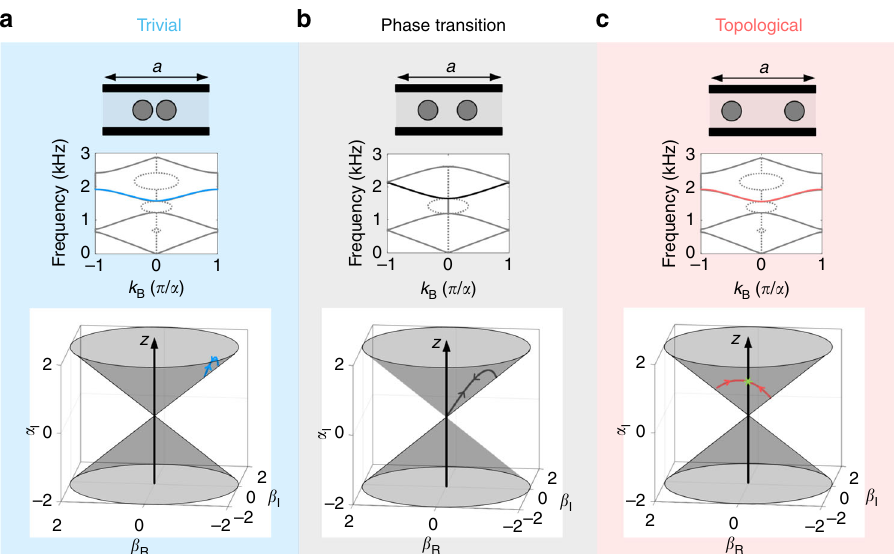
Fig. 6 Topology of the bands. We de fi ne the topology of the bands as the number of times the contours C crosses the axis of the cone de fi ned in Eq. 20. a For the trivial lattice, the contour C does not cross the axis of the cone, corresponding to a zero topological invariant. b When the system goes through phase transition, the contour C touches the tip of the cone. The topological invariant cannot be de fi ned in this case. c Same as panels ( a ) and ( b ) but for the topological lattice. The contour C crosses the axis of the cone one time in this case, which corresponds to a nontrivial two bands touch, the contour C is reaching the tip of the cone, as con fi rmed by Fig. 6b. Topology of the bands . As seen in previous sections, each band de fi nes a mapping between the Brillouin circle and a subspace of SU(1,1) matrices. We now de fi ne a